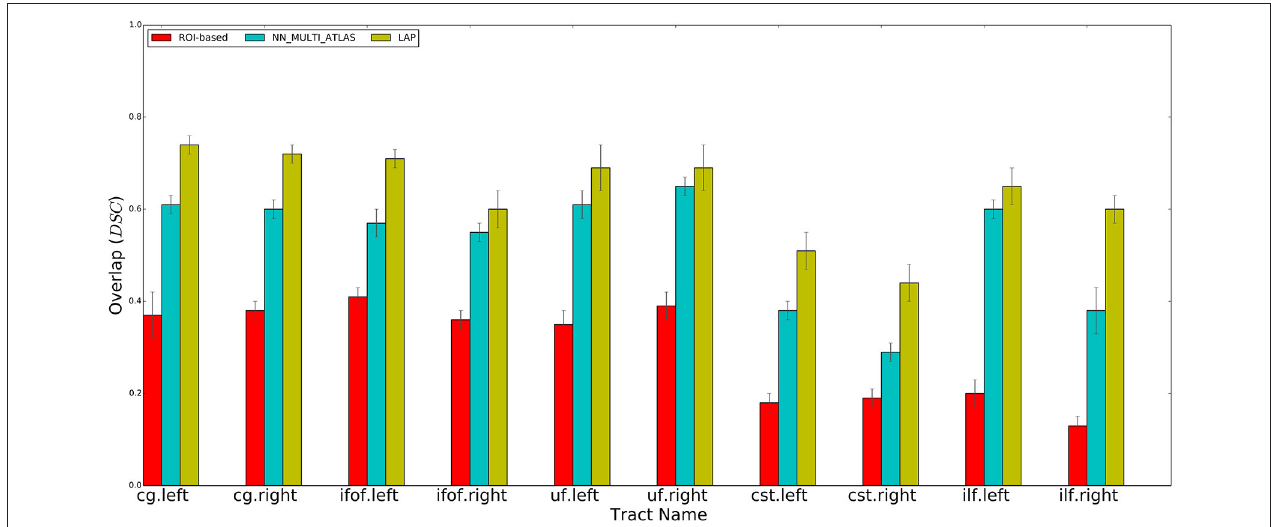
FIGURE 4 | Summary of the results: average voxel overlap between segmented tracts and ground truth tracts for the ROI-based, NN_MULTI_ATLAS, and the proposed LAP. The bar graph shows the degree of overlap, in terms of dice similarity coefficient (DSC), for each tract averaged over 15 subjects.